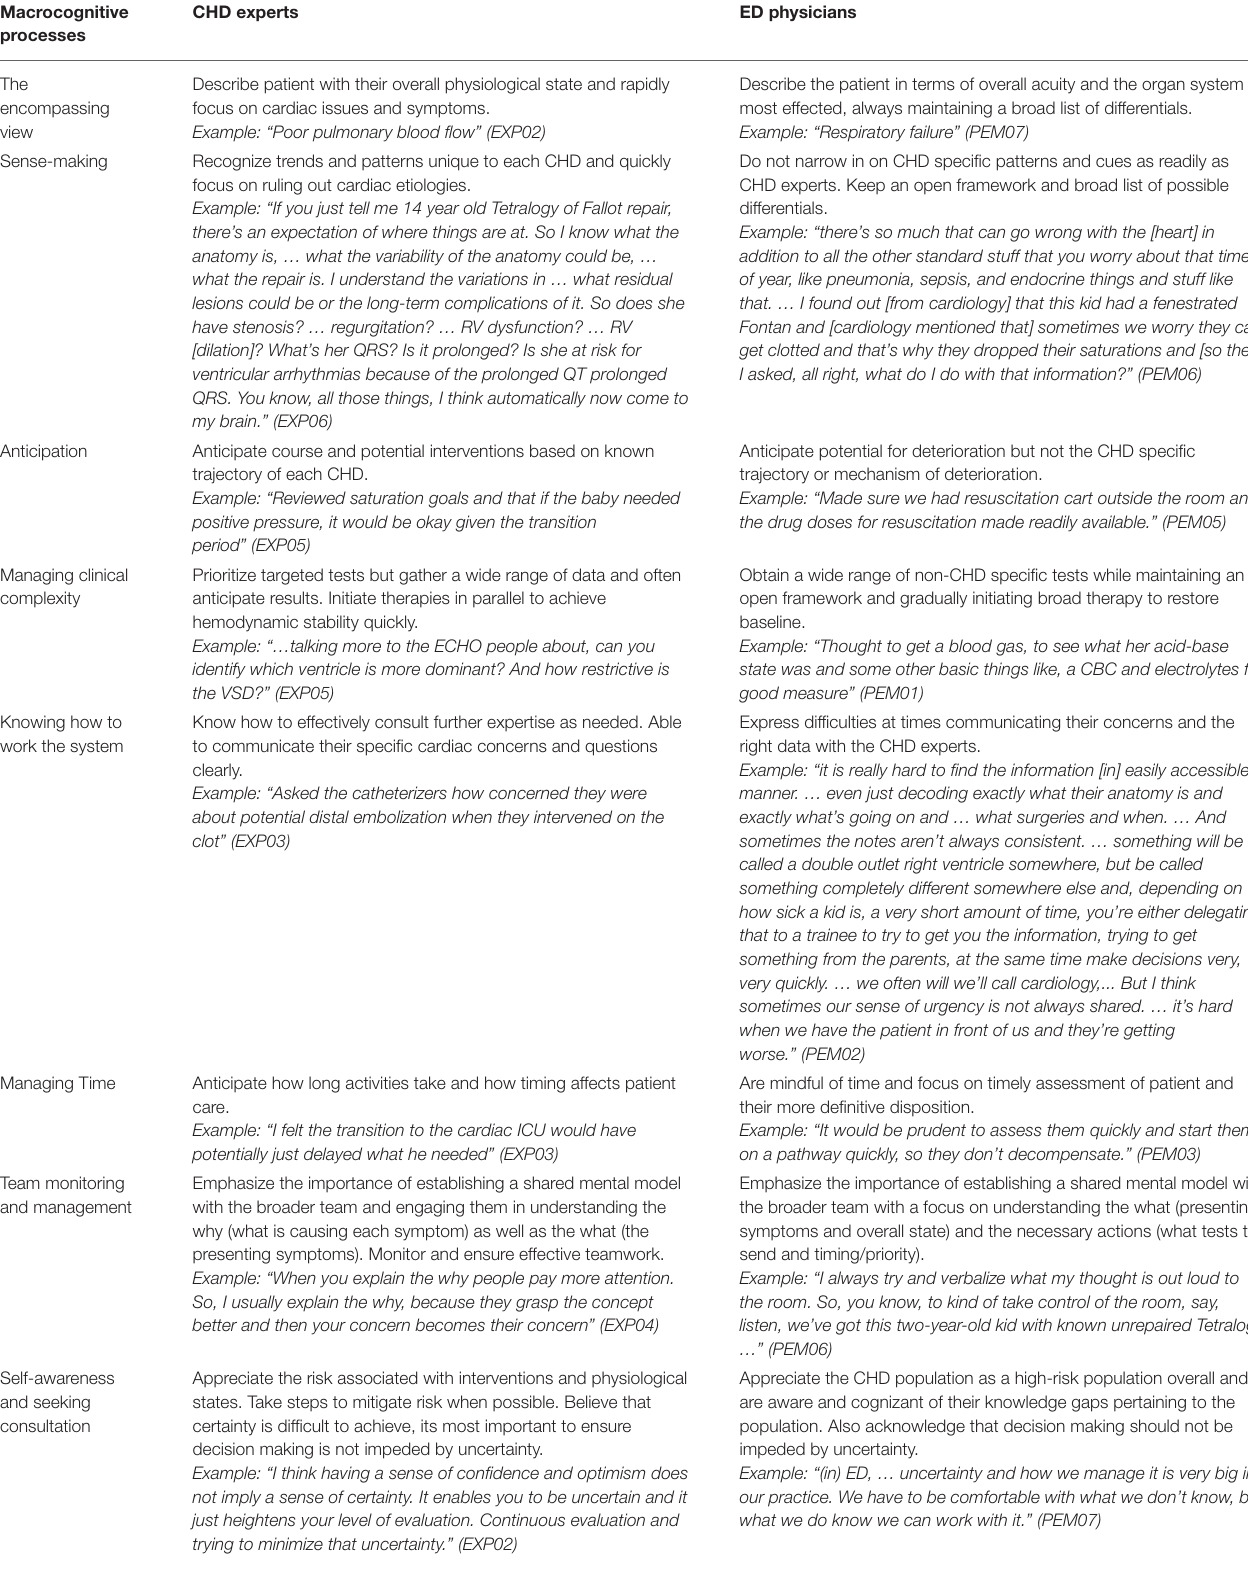
TABLE 2 | Differences between macrocognitive processes of CHD experts and ED physicians when managing pediatric CHD. Macrocognitive CHD experts ED processes